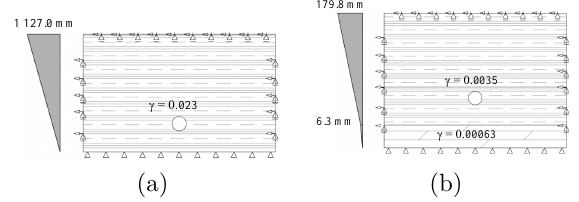
Figure 6. Kinematic loading conditions: a) fixed boundary, b) absorbing